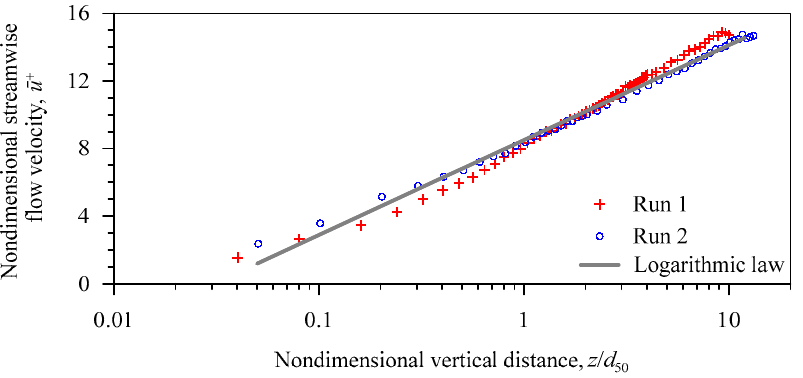
Figure 4. Vertical profiles of nondimensional streamwise flow velocity ū + at the upstream of isolated dunal bedforms for Runs 1 and 2.